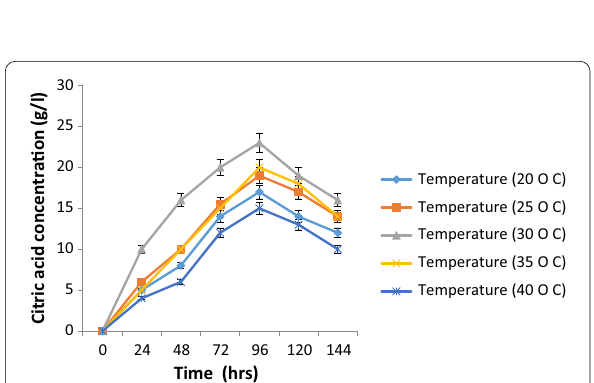
Fig. 5 Effect of incubation temperature on citric acid production from wild